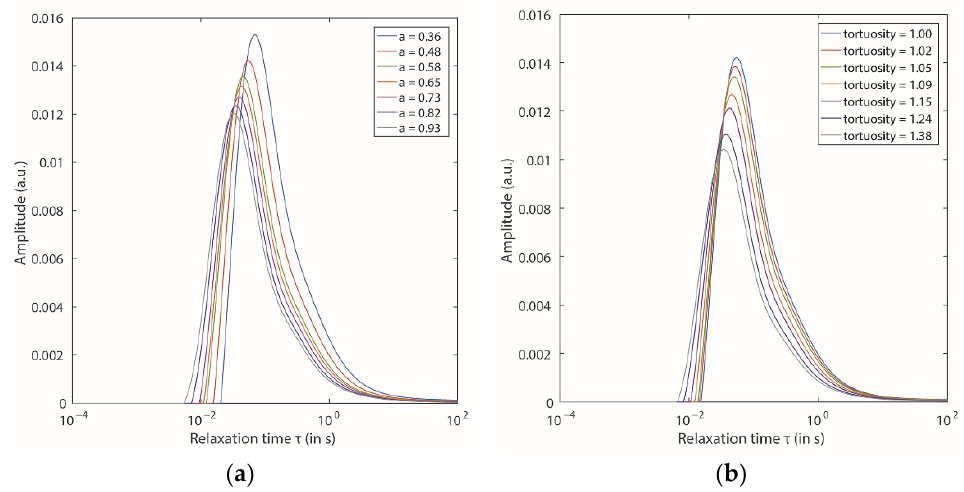
Figure 7. Dependence of the relaxation time distributions of seafloor sulfide-bearing rocks on the aspect ratios and tortuosities of metal sulfides. ( a ) The relaxation time distributions for seafloor massive metal sulfide models with various aspect ratios. ( b ) The relaxation time distributions for seafloor vein metal sulfide models with various tortuosities.